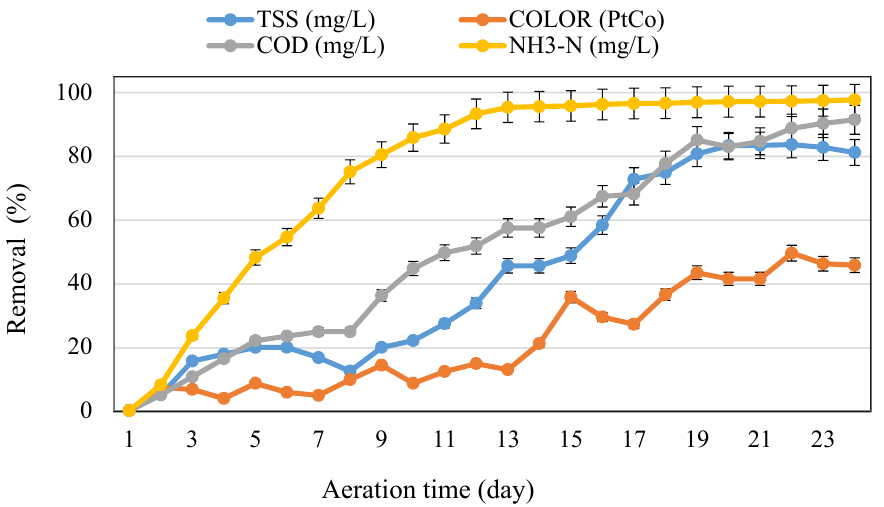
Figure 2. E ff ects of reaction time variation on COD, TSS, color, and NH 3 -N removal e ffi ciency (with natural pH, leachate / POME (900 mL leachate / 100 mL POME), aeration power 20 L /